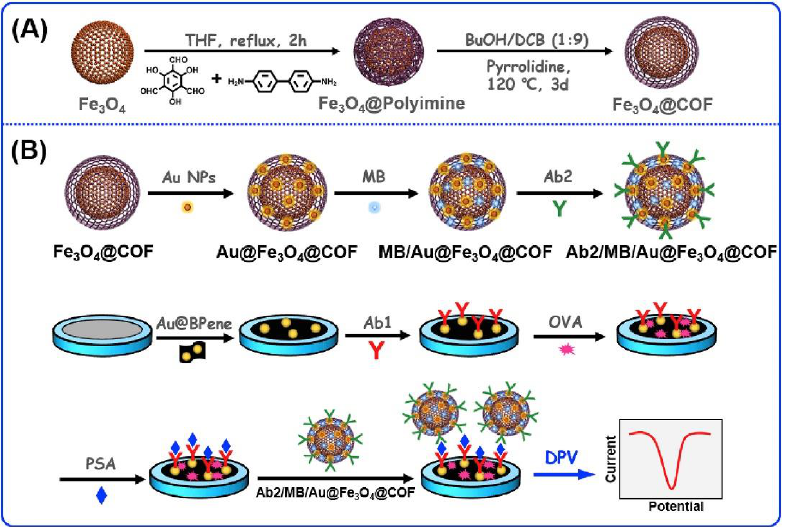
Figure 6. Synthesis of the Fe 3 O 4 @COF nanohybrid by H. Liang et al. [114] ( A ) and assembly of the immunosensor for the PSA and signal conversion strategy ( B ). Reprinted with permission from Ref. [114]. Copyright 2019 Elsevier.